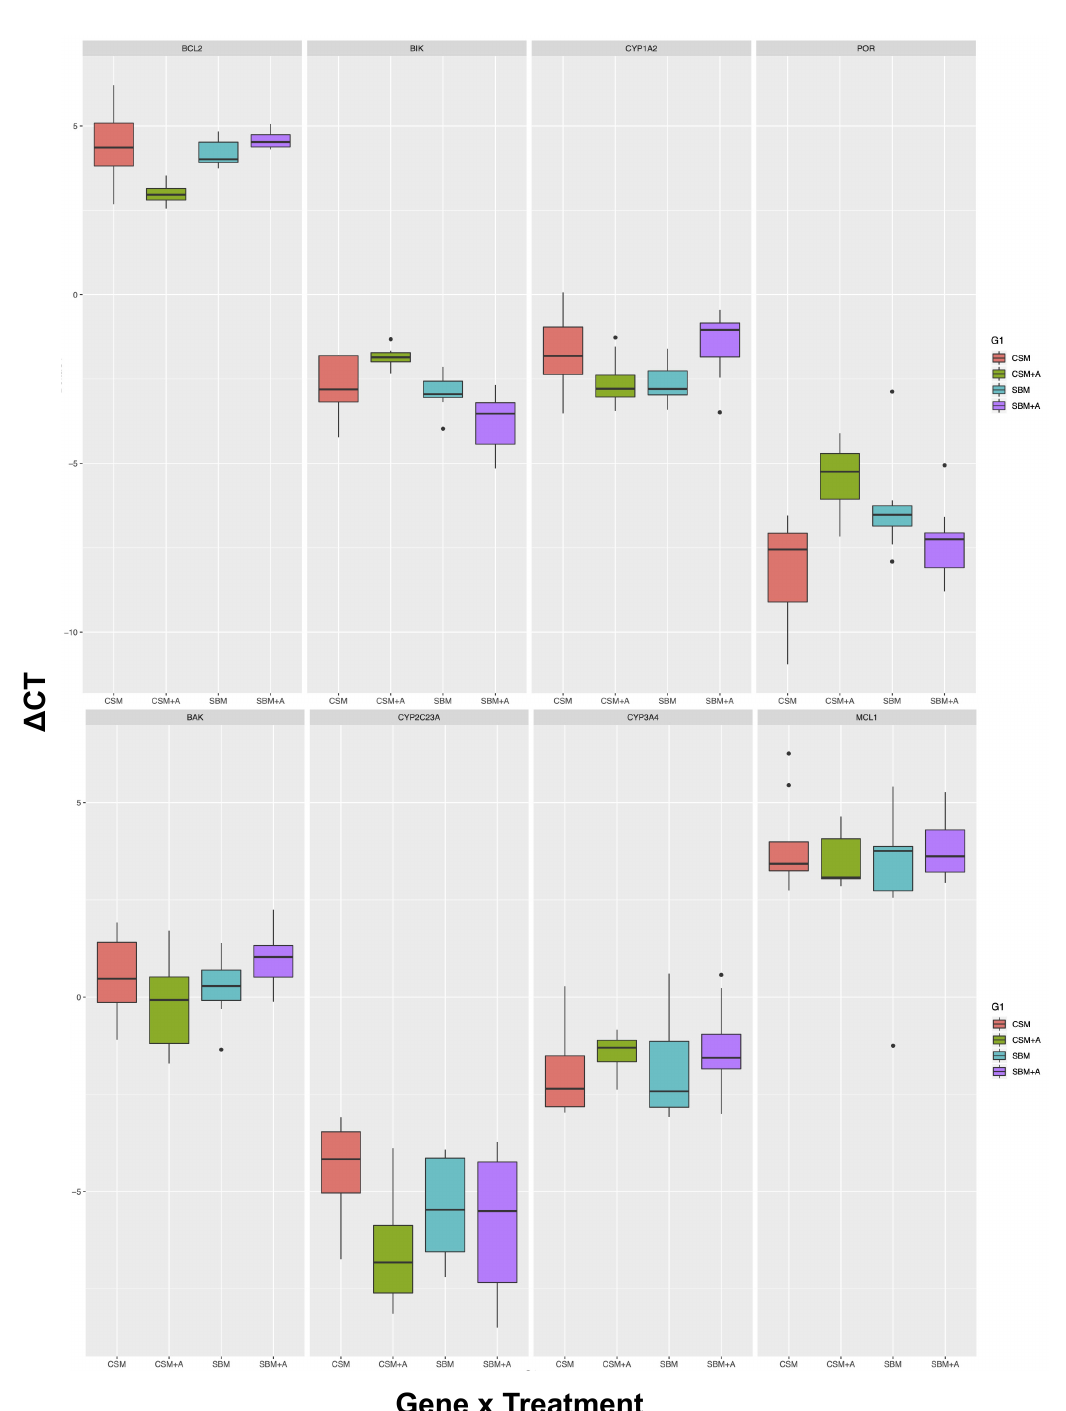
Figure 2. Boxplots showing the differential expression of homeostatic genes in the spleens of laying hens raised on SBM, CSM, SBM + YCW, and CSM + YCW diets. The y-axis values are ∆ CTs, and each dietary treatment is represented by different colors. The gene of interest is named at the top of each panel.